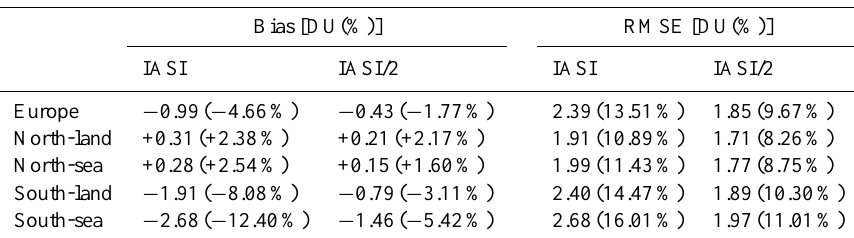
Table 2. Mean biases and RMSEs for IASI and IASI/2 surface–6km TOC pseudo-observations with respect to raw MOCAGE pseudo-reality, calculated in the whole Europe, north-land pixels, north-sea pixels, south-land pixels and south-sea pixels. The north/south limit latitude is 52.5 ◦ N. Percent values are reported in parentheses.